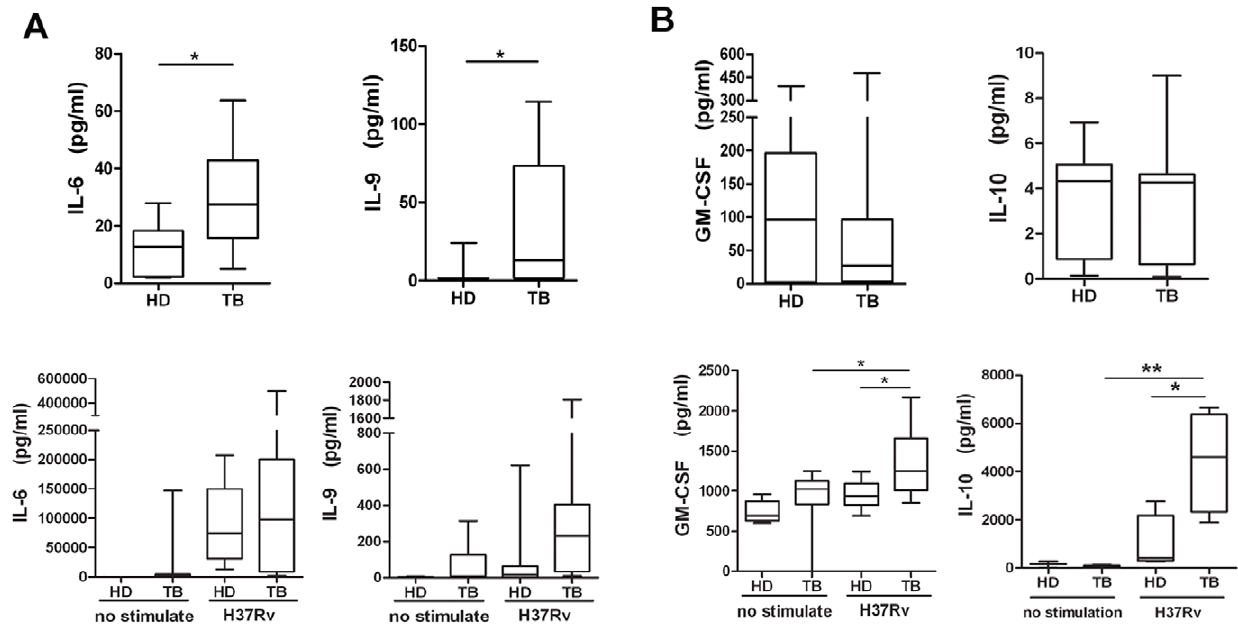
Figure 3. Comparison of cytokine expression in plasma or invitro after M.tb antigen-specific stimulation of PBMCs. A: Data for IL-6 and IL-9 levels in pulmonary tuberculosis patients (TB) and HDs are shown. PBMCs from healthy donors and TB patients were collected for M.tb antigen-specific stimulation in vitro . The IL-6 and IL-9 expression levels in stimulated cell cultures are shown in the panels below. B: GM-CSF and IL-10 levels in plasma from TB patients and healthy donors or in PBMCs following antigen-specific stimulated cell culture. Horizontal bars represent median values, boxes represent the interquartile range (25–75%) and whiskers represent the highest and the lowest values. Horizontal lines indicate a statistically significant difference between groups. *p , 0.05; **p , 0.005.